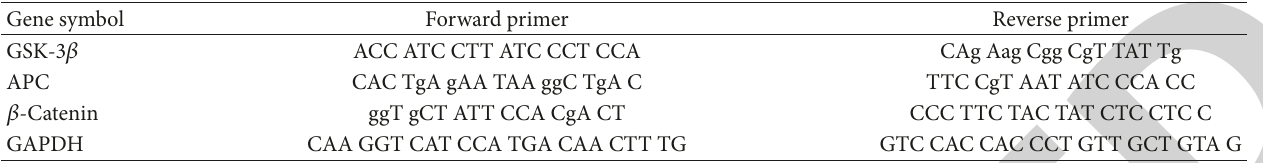
Table 1: The Primer information of these four